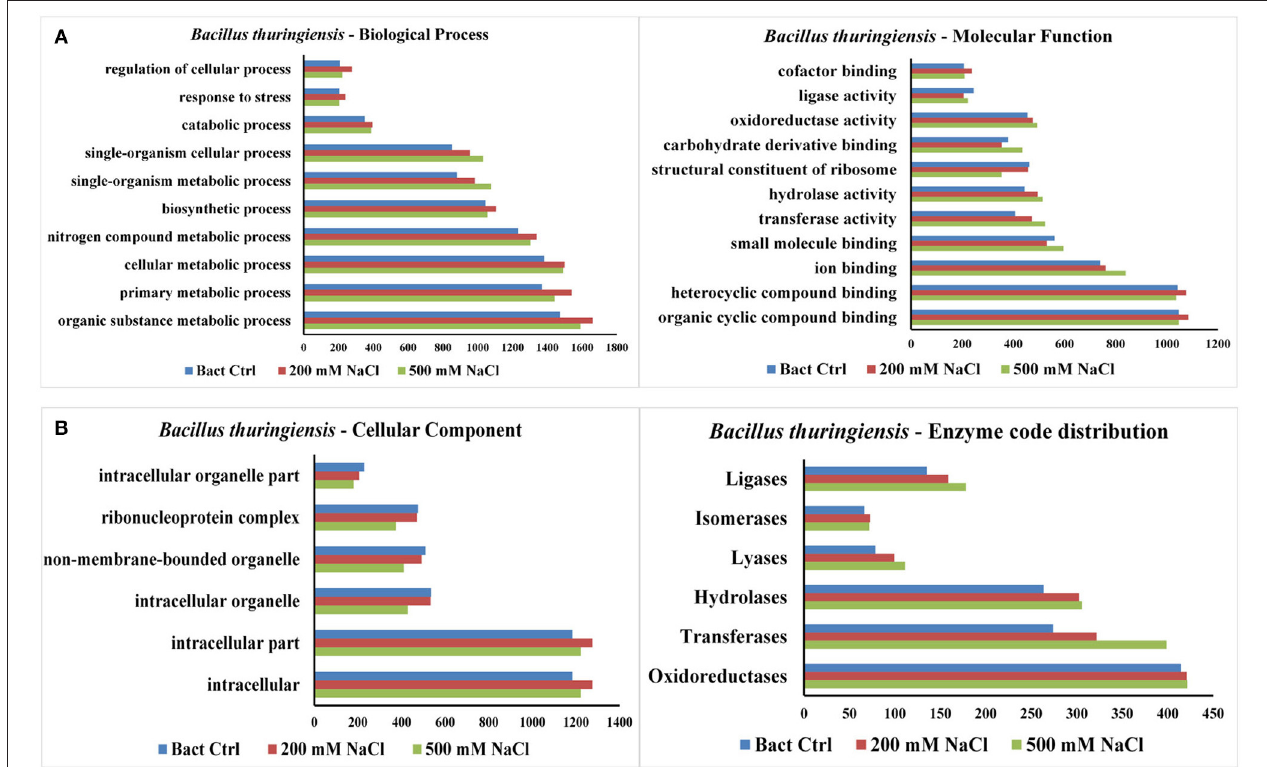
FIGURE 4 | (A) Representation of functional classification of proteins based on GO function distribution for biological process and molecular function in control and NaCl stressed bacterial culture. (B) Representation of functional classification of proteins based on GO function distribution for cellular component and enzyme code distribution.